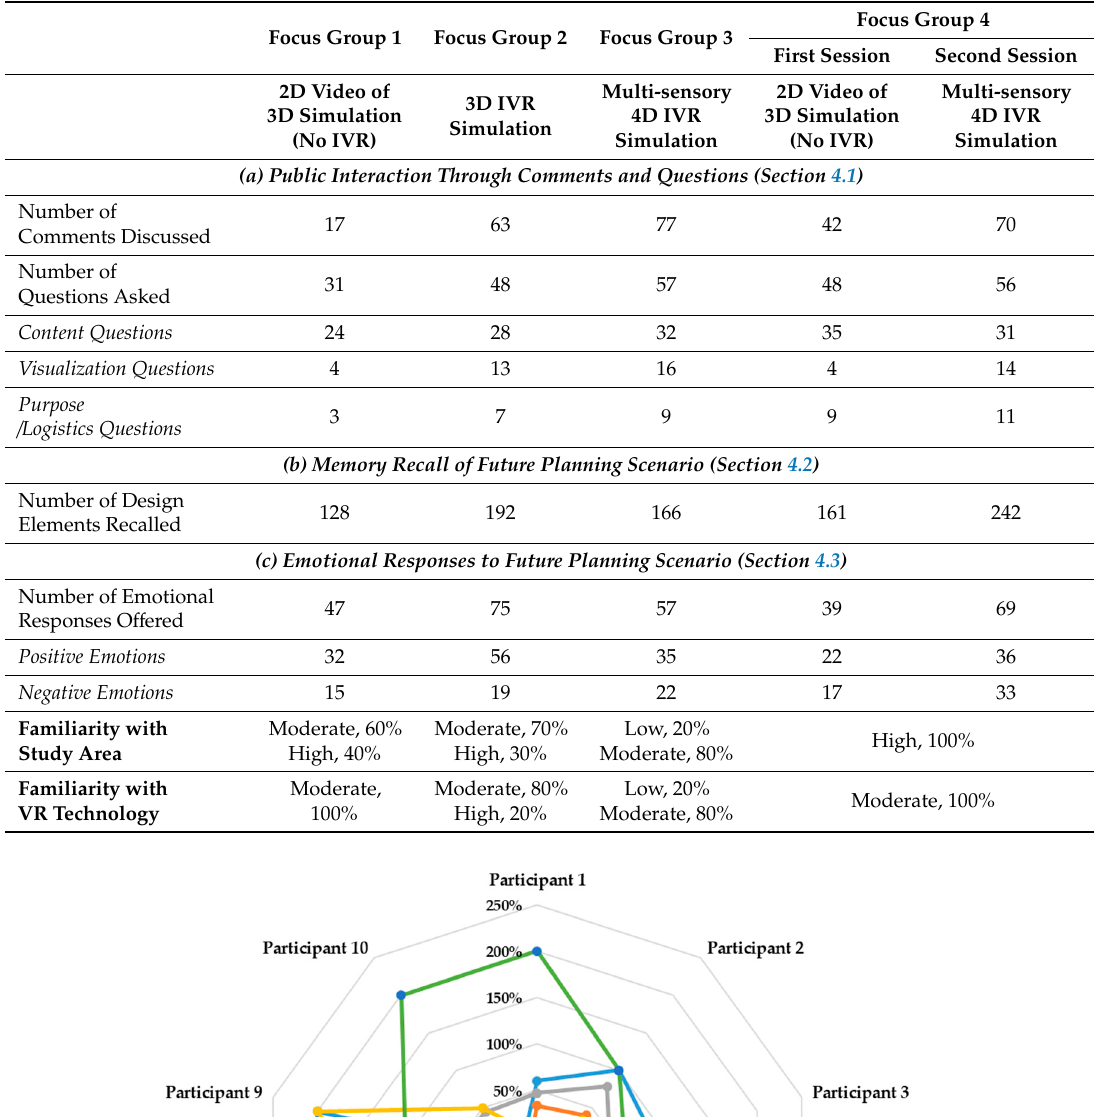
Table 1. A compilation of data collected from four focus groups.